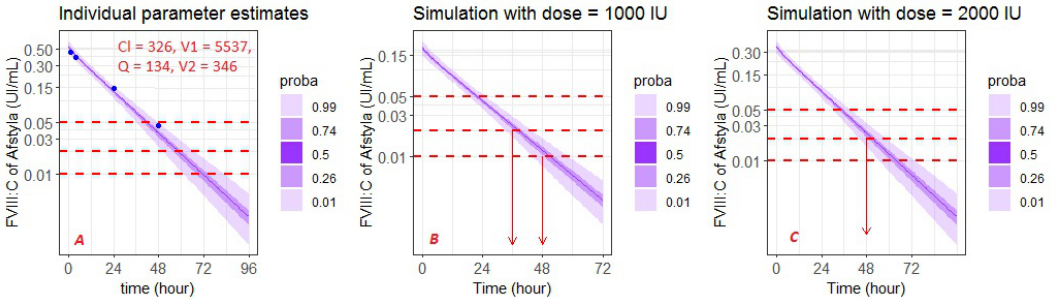
Figure 7. Estimated individual parameters ( A ) and rational adaptation dosing regimen of one individual ( B , C ). Blue dots are observed data.